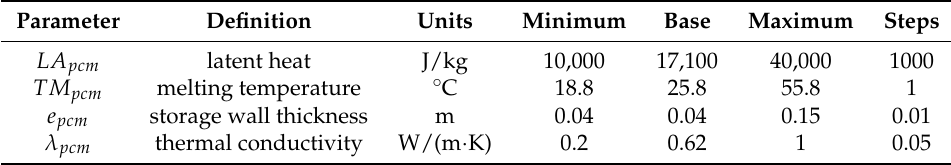
Table 2. Solar Trombe wall parameters: definition, respective ranges and